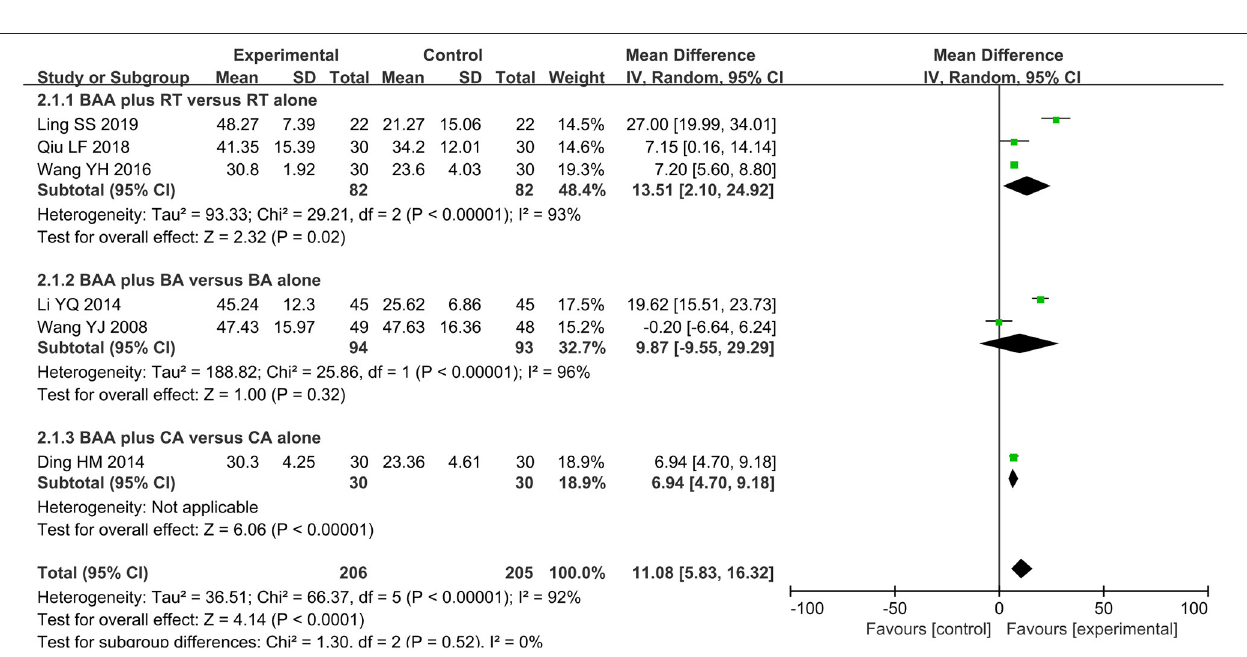
Frontiers in Neurology |